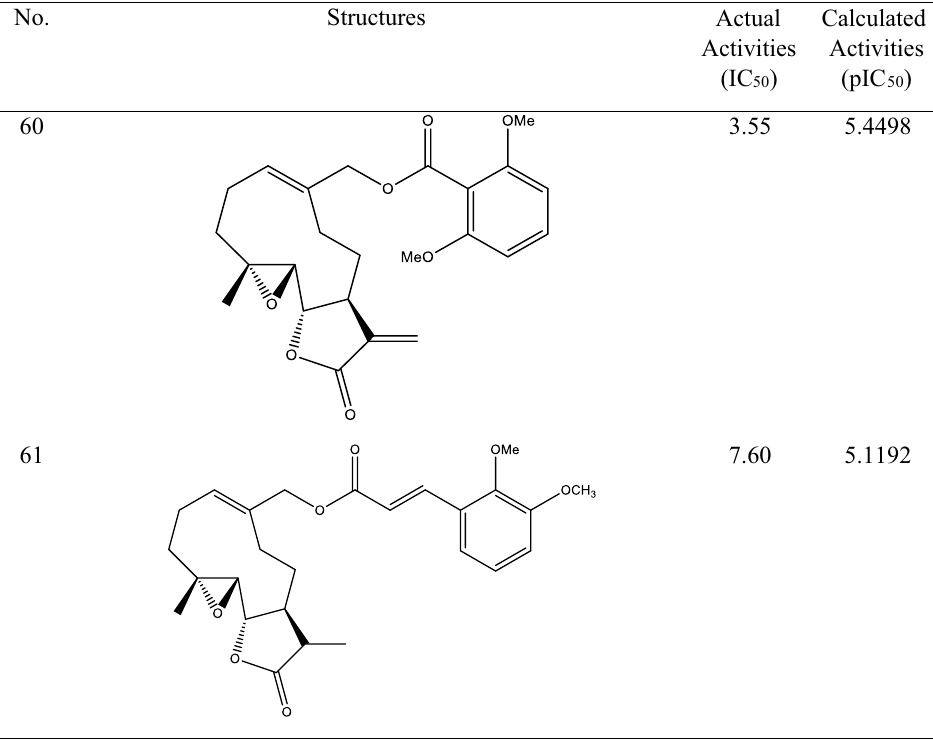
Table 5 The inhibitory activities of parthenolide derivatives No.